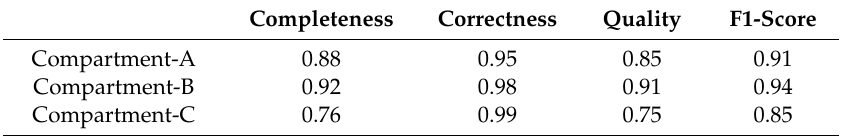
Table 4. Calculated values for completeness, correctness and quality by using TP, FP, and